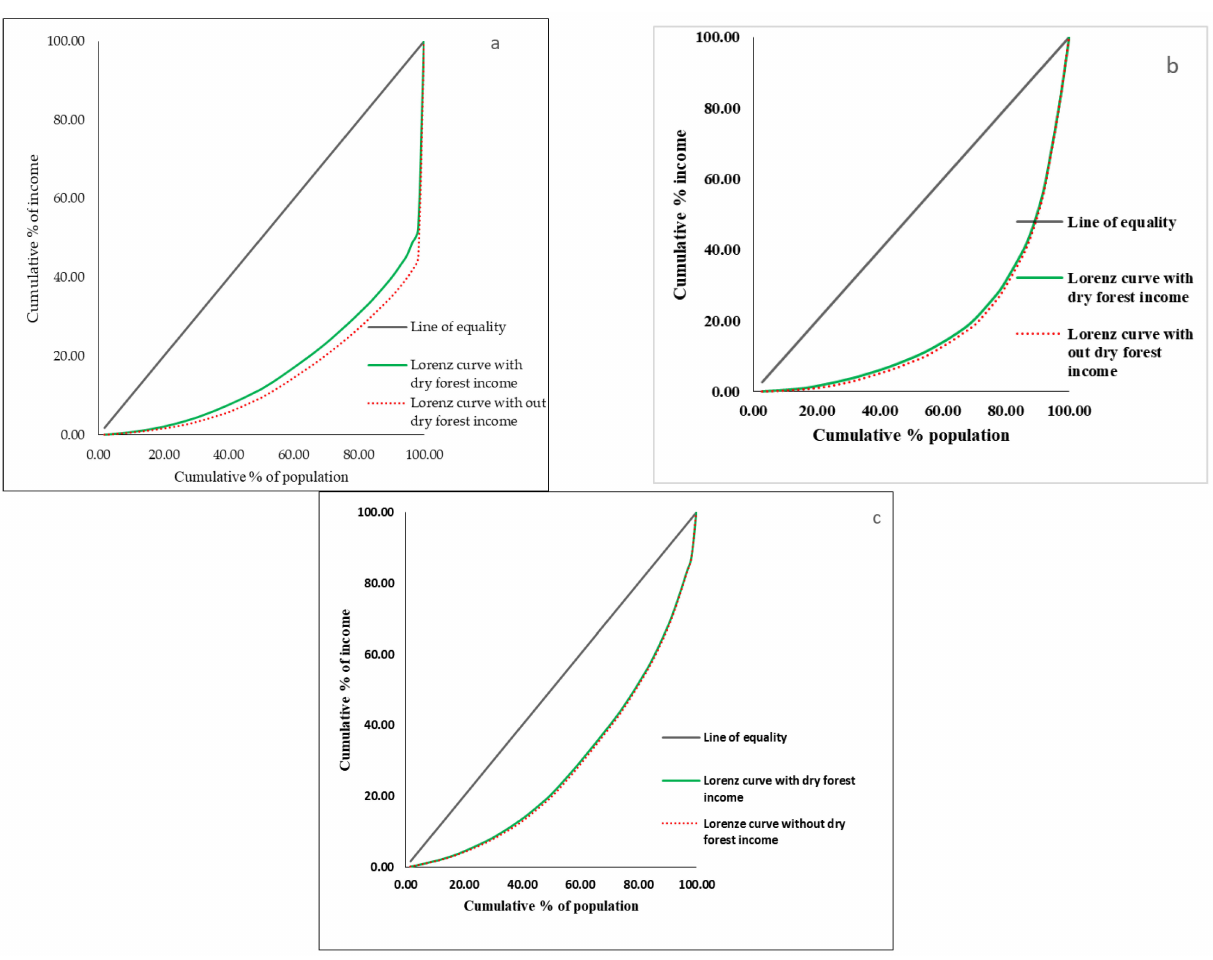
Figure 6. Schematic presentation of the Lorenz curve showing income equalizing effect of dry forests in AW ( a ) KH ( b ) and RA Districts ( c